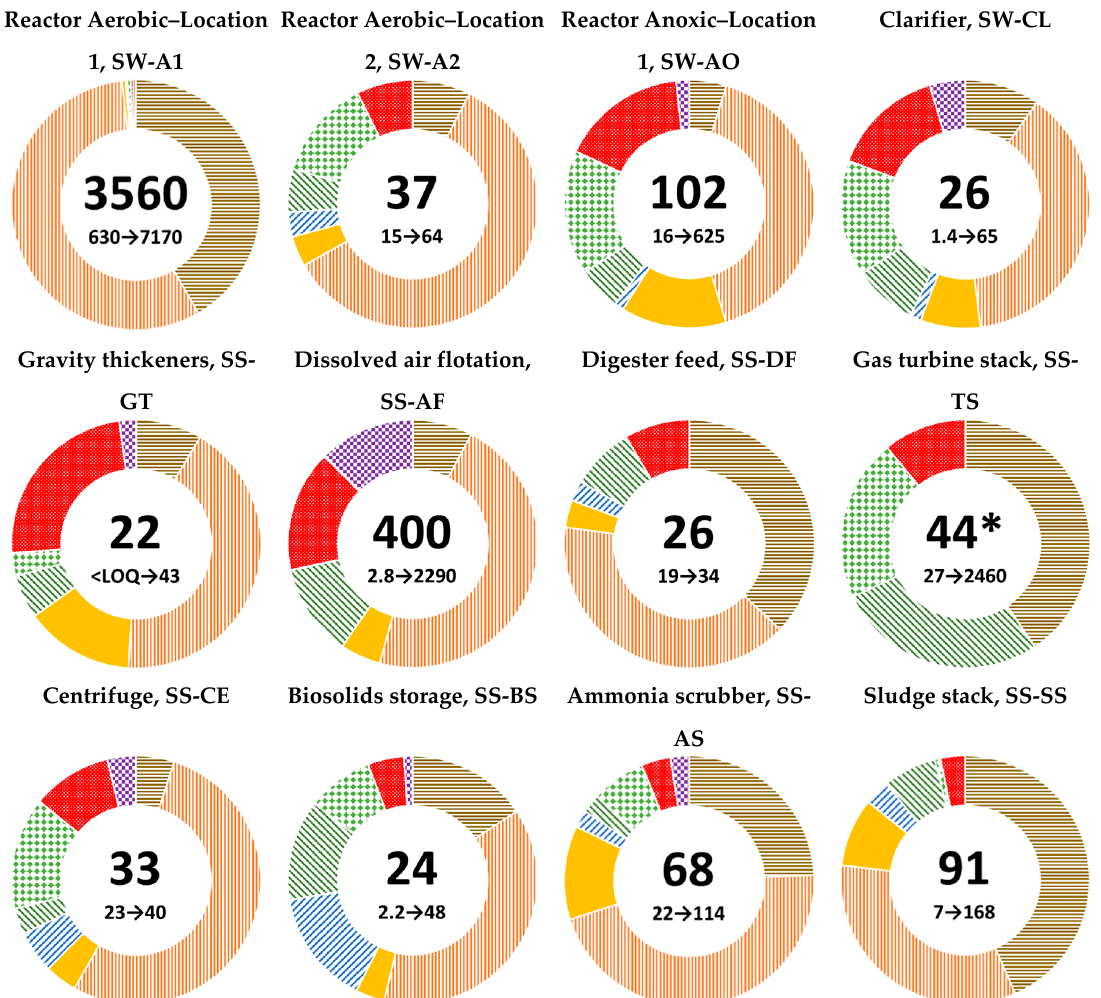
Figure 6. Dominant odorants/groups of odorants with similar notes for each odor source as a proportion of total odor activity measured using SIFT-MS. The large number in the center of each chart is the total OAV for the individual samples averaged across the samples of that type (except for the outlier in one of the gas turbine stack samples*). The small numbers show the range of total OAVs. *For the gas turbine, the outlier was eliminated since many sulfur compounds were not measurable.